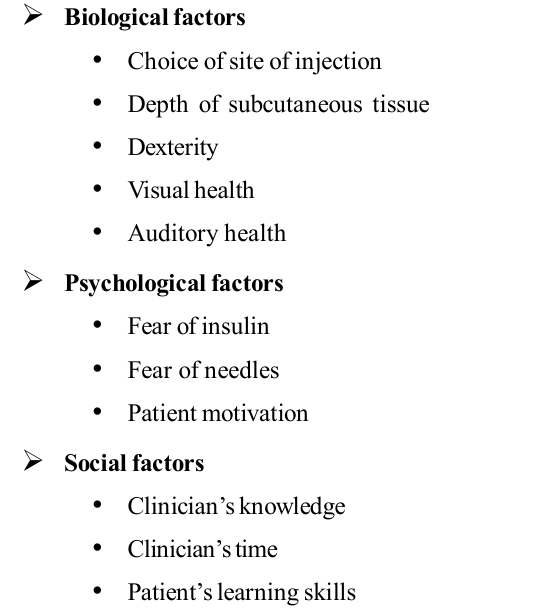
Table 1. Factors influencing insulin injection